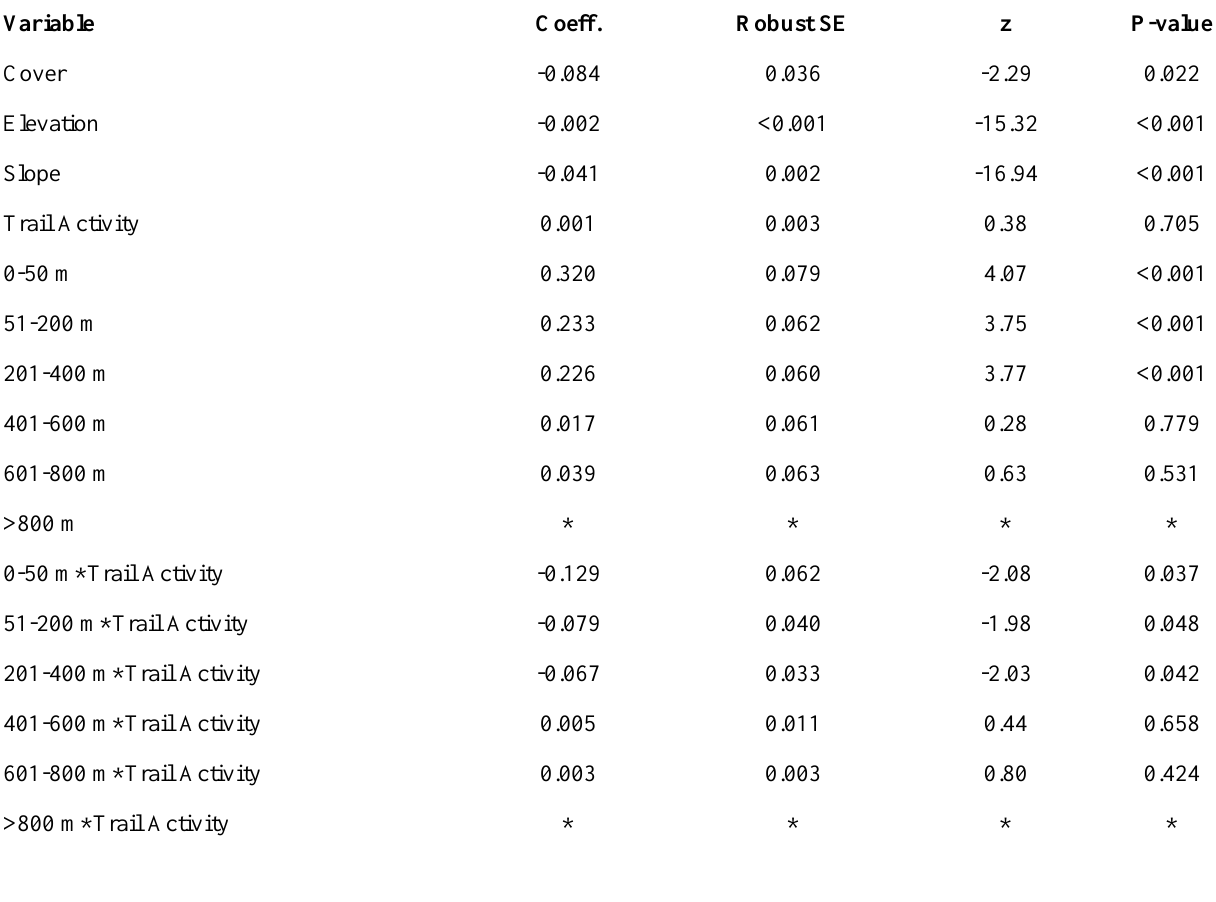
Table A1.1. Model results for wolves and trails. Results predict wolf occurrence near trails using matched case-control logistic regression.